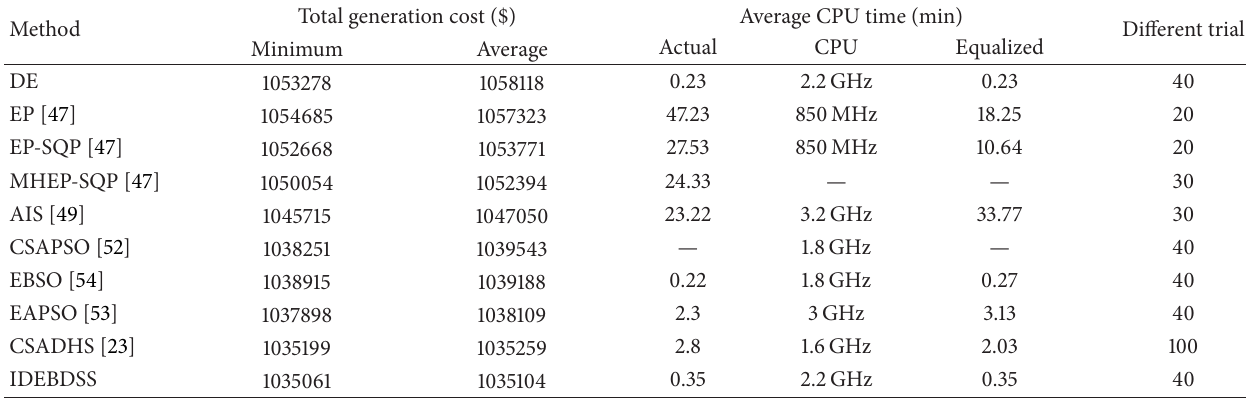
Table 4: Comparison of results with different methods for test system 2.